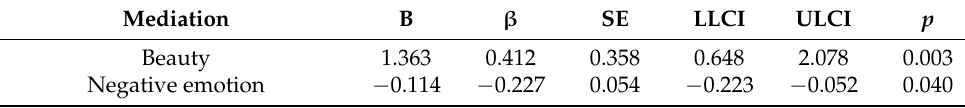
Table 4. Mediation of the relationship between beauty and tastiness by negative emotion.